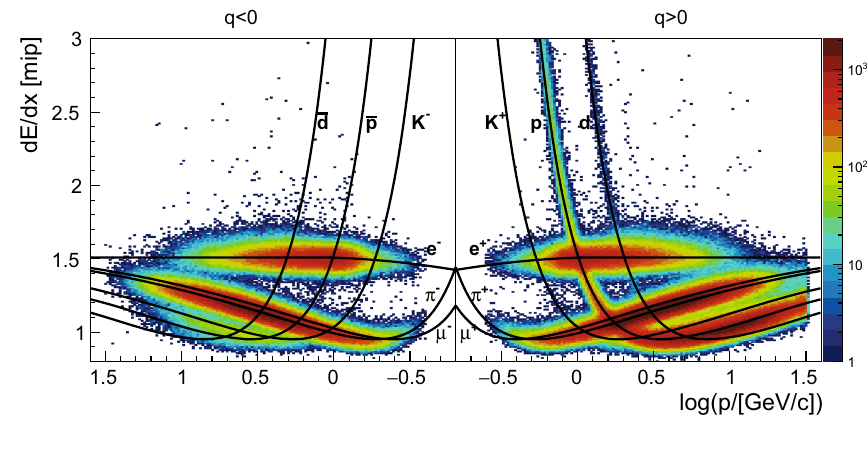
Fig. 11 The p − θ distribution of protons emitted from the surface of the T2K target which contribute to the (anti)neutrino flux in Super- Kamiokande . The top row shows the phase space plots in the forward Fig. 12 Distribution of specific energy loss in the TPCs as a function of particle momentum for negatively (left panel) and positively (right panel) charged particles